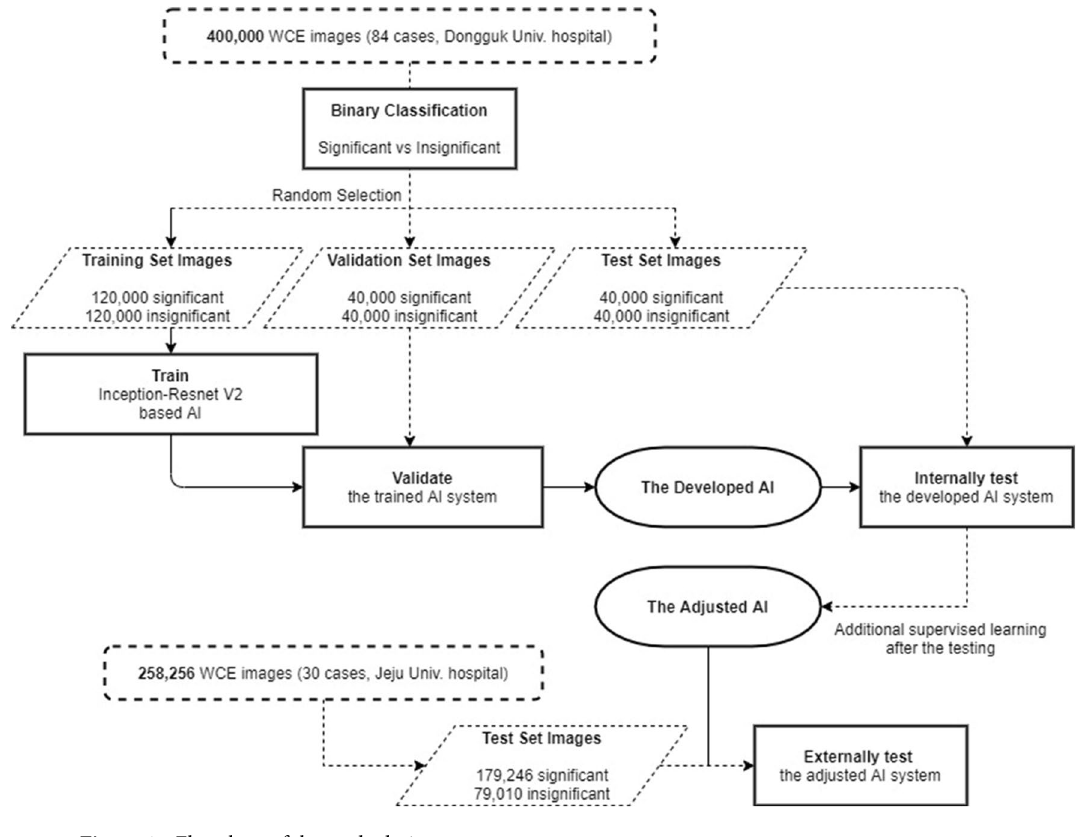
Figure 1. Flowchart of the study